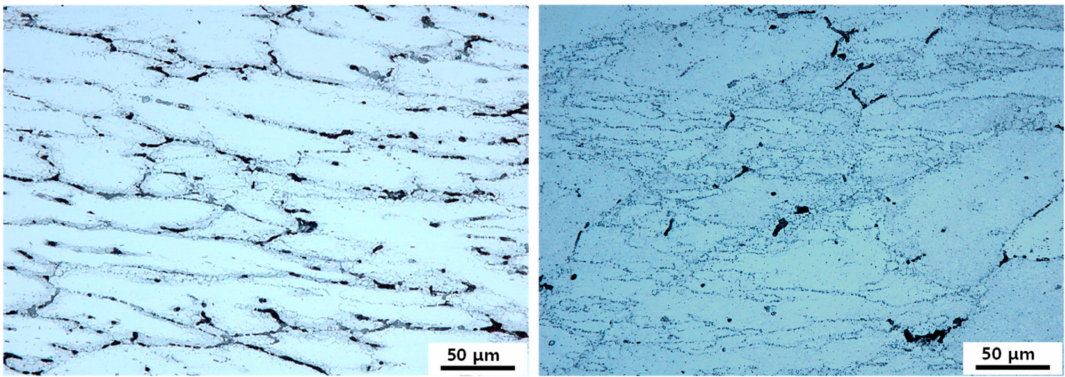
Figure 11. The optical micrographs of ( a ) the as-cast alloy and ( b ) the extruded alloy after compression tests at 723 K–10 s − 1